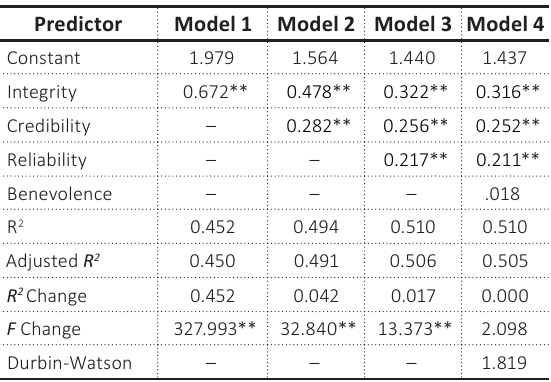
Table 5. Hierarchical regression